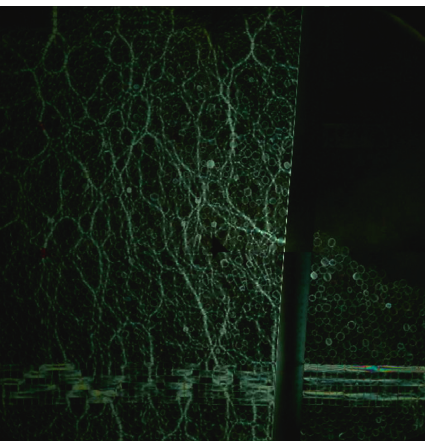
Figure 9: Force chains after the third excavation (excavation